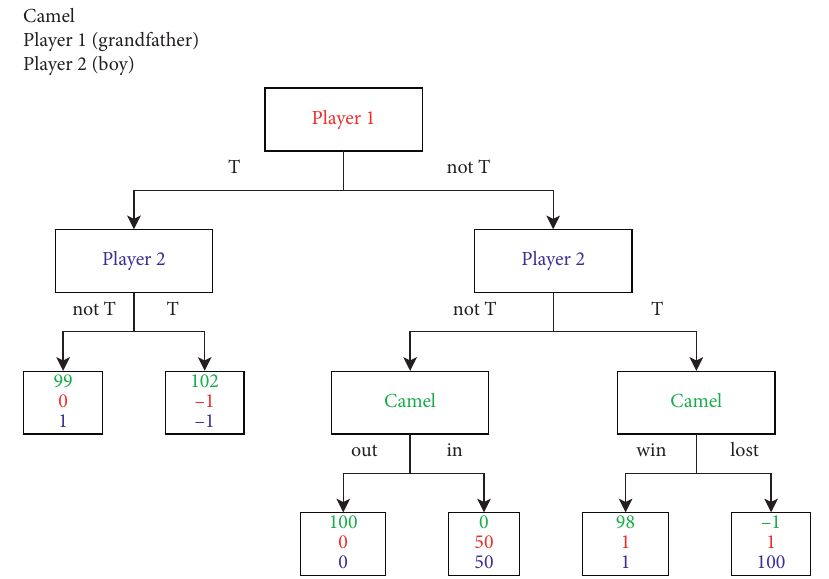
Figure 3: Perfect-information